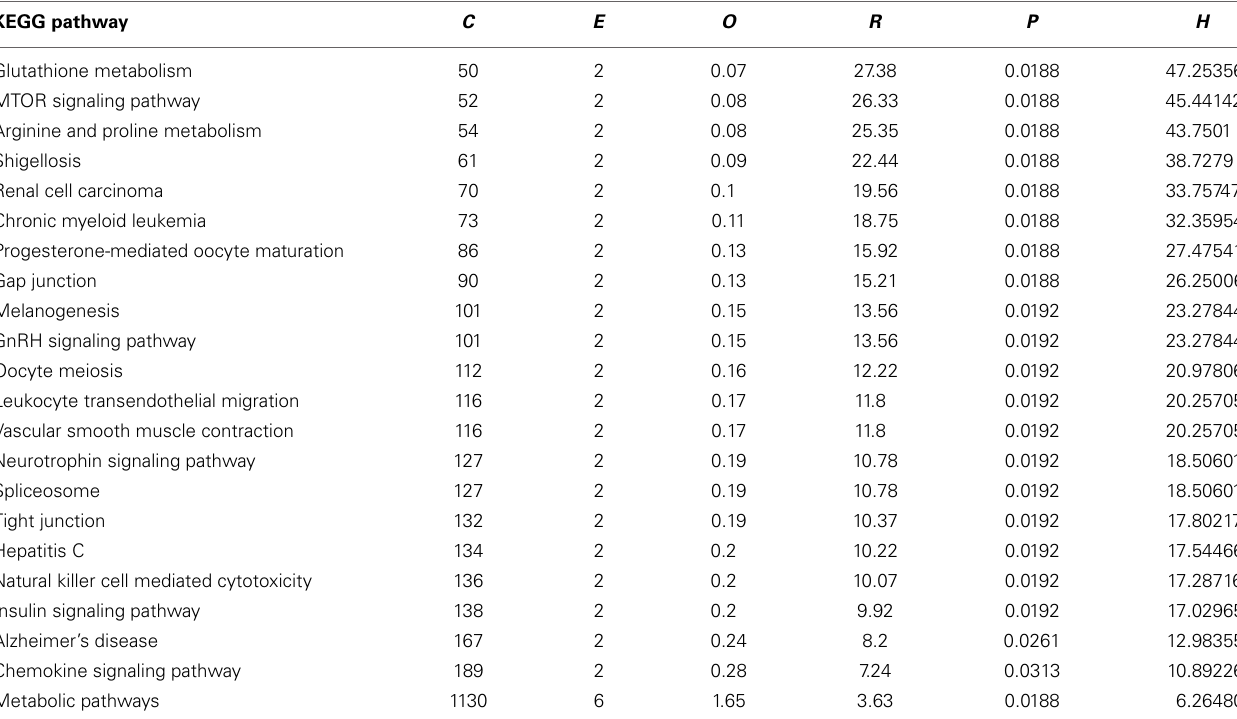
Table 3 | KEGG Pathway analysis for cortical proteins altered in BTBR mice compared to WT controls. KEGG pathway C E